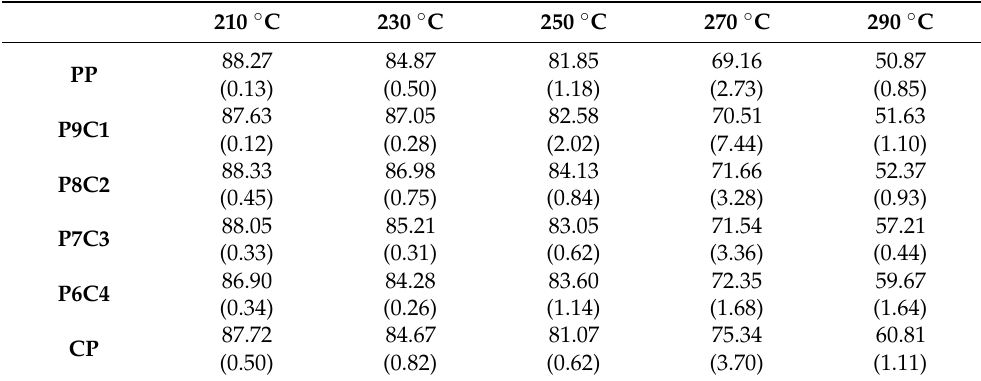
Table 6. Mass yield after torrefaction